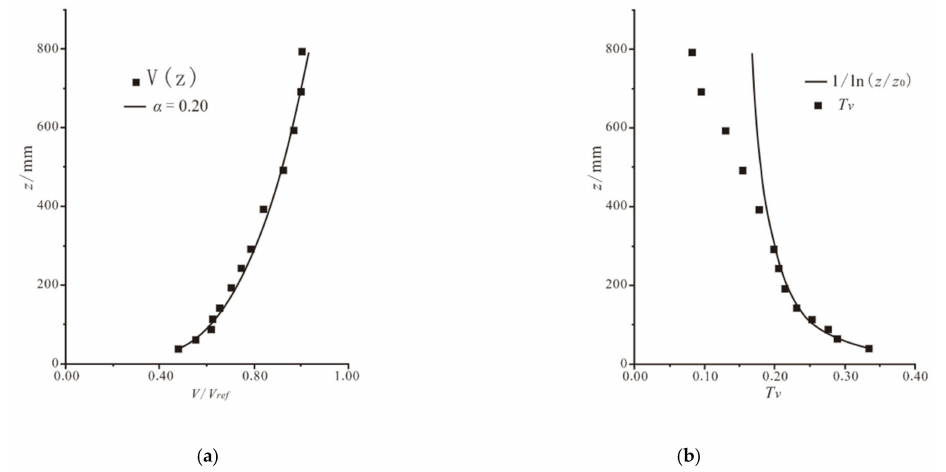
Figure 3. Wind flow diagram of the atmospheric boundary layer simulated in the wind tunnel. ( a ) V / Vref—z curve; ( b ) Tv—z curve.